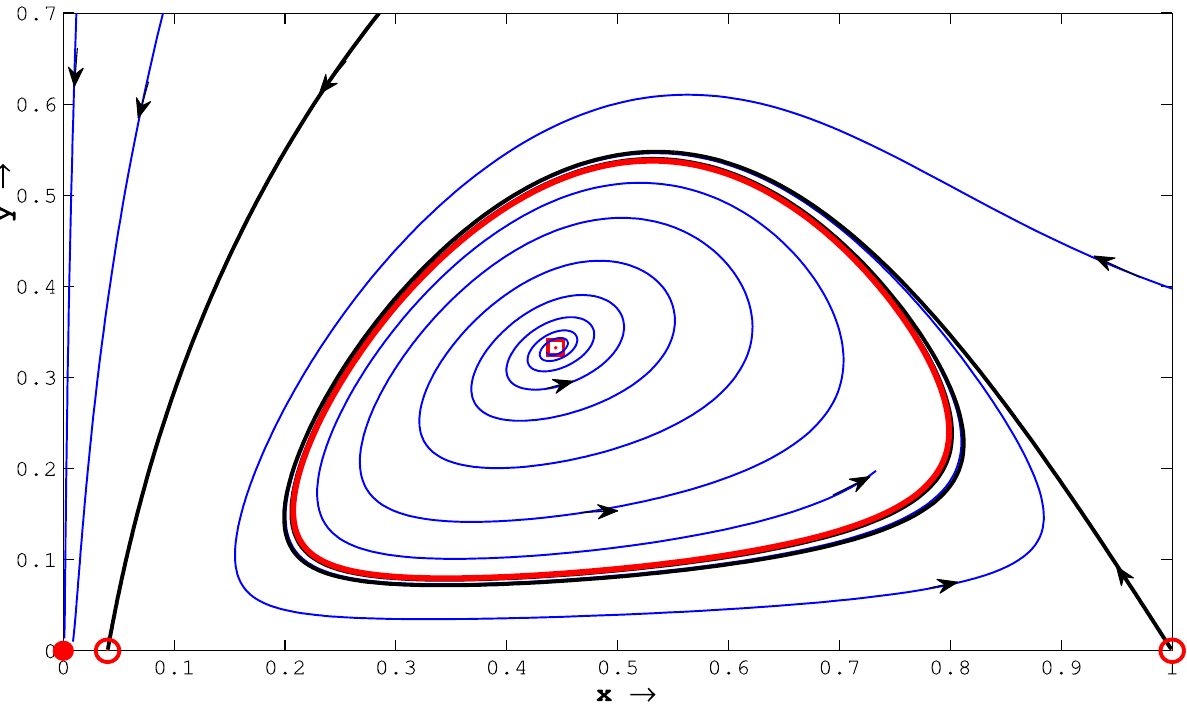
Figure 5. (Strong Allee effect:) the fixed point(0, 0) is stable (shown by filled circle) whereas (0.04, 0) and (1, 0) are saddle points (shown by open circles). The single interior fixed point is unstable and shown with a square open box. This unstable fixed point is surrounded by a stable limit cycle which is shown as a thick red curve. The limit cycle attracts the neighboring trajectories. The stable manifold of (0.04, 0), shown by black curve passing through (0.04, 0), acts as a separatrix curve that splits the dynamics of trajectories of the model into two regions in the phase plane; the trajectories initiated from the region left to this black curves enter (0, 0) and the basins of attraction of the stable limit cycle is the domain right to it. The other black curve through (1, 0) is unstable manifold of the fixed point(1, 0). The parameter values used for this figure are l = 0.04 ; β = 1.1 ; a = 0.5 ; b = 1.0 ; d = 0.3